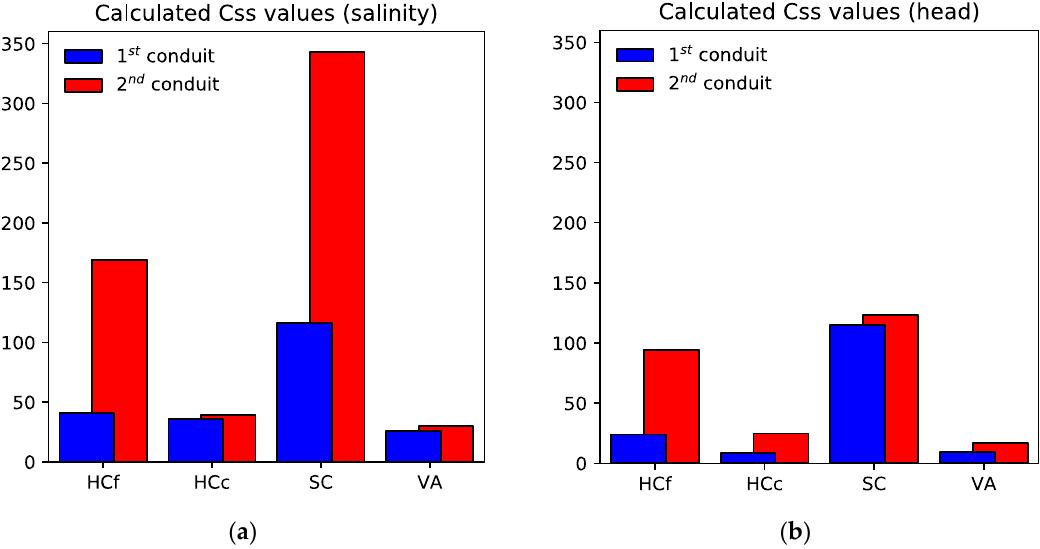
Figure 4. ( a ) Calculated composite scaled sensitivity (Css) values of all parameters (HCf, HCc, SC and VA) with respect to salinity numerical simulations in the conduit (layer n. 10, 16) and j = 16, in the local sensitivity analysis; ( b ) Calculated Css values of all parameters with respect to head numerical simulations in the conduit (same as ( a )). HCf, HCc, SC and VA represent the hydraulic conductivity (fractured medium), the hydraulic conductivity (conduits), salt concentration and vertical anisotropy, respectively.